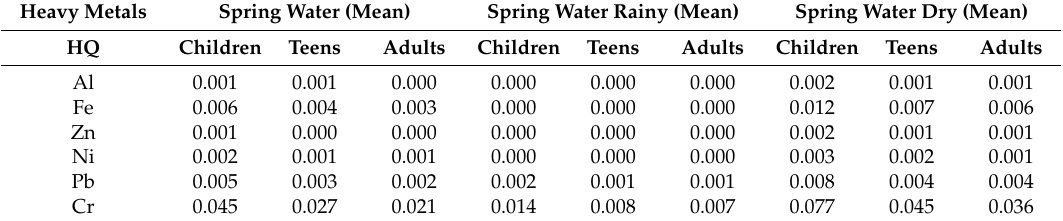
Table 4. HQ and HI, for the water intake of the spring water, in the subpopulation of children, teenagers and adults of E. Portes Gil.